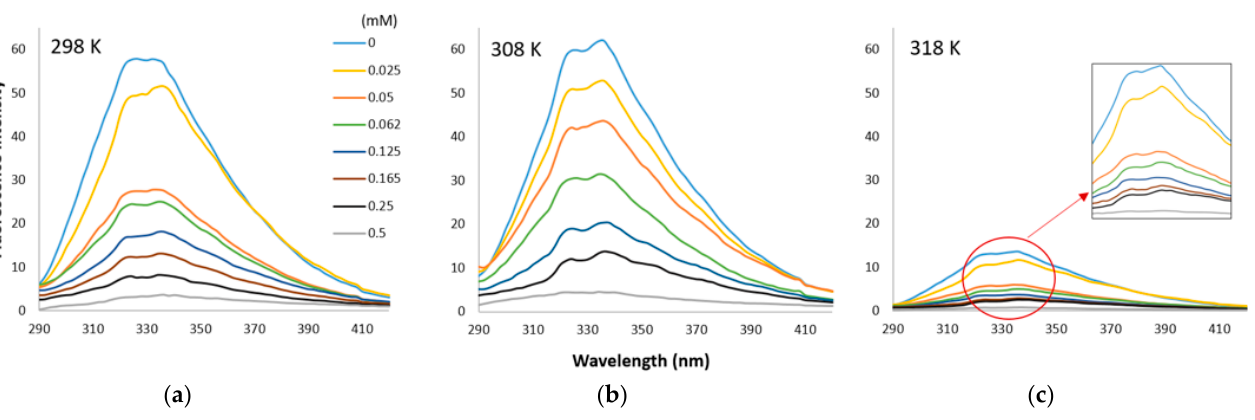
Figure 3 . Fluorescence emission spectra (at λ ex 280 nm) of dHPI+HSE complex at 298 ( a ), 308 ( b ), and 318 K ( c ) in phosphate buffer solution at pH 7 with an increase in HSE concentration (0–0.5 mM). Each curve represents a triplicate assay after correction for phenol extract fluorescence. A broad and slightly shouldered peak was observed in the hazelnut protein itself, independent of phenol. This type of fluorescence intensity peak indicates the presence of